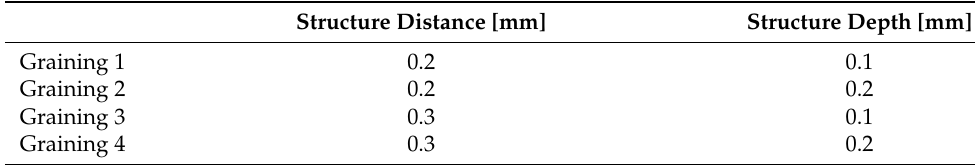
Table 2. Structural distances and depths of graining